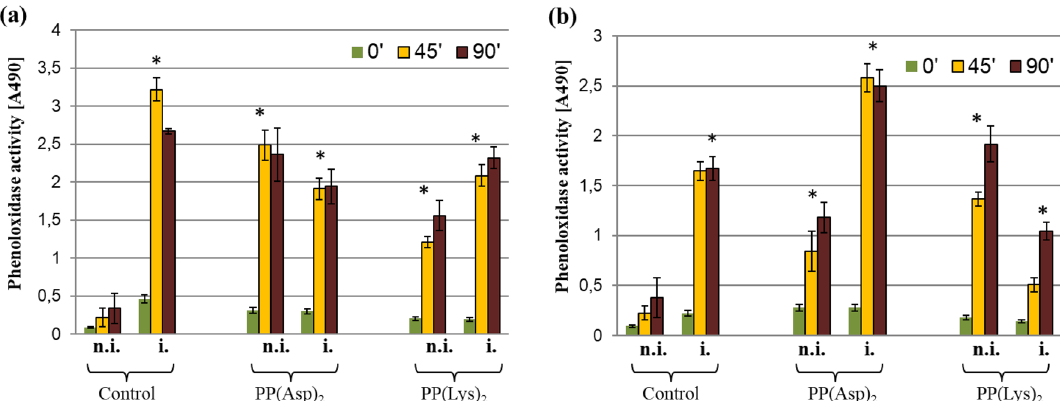
Figure 6. Phenoloxidase activity in honeybees on days 3 ( a ) and 4 ( b ) post infection; n.i.—non-infected honeybees; i.— Nosema -infected honeybees; Controls—honeybees fed with pure sucrose syrup; PP(Asp) 2 and PP(Lys) 2 —honeybees fed with sucrose syrup containing porphyrin.